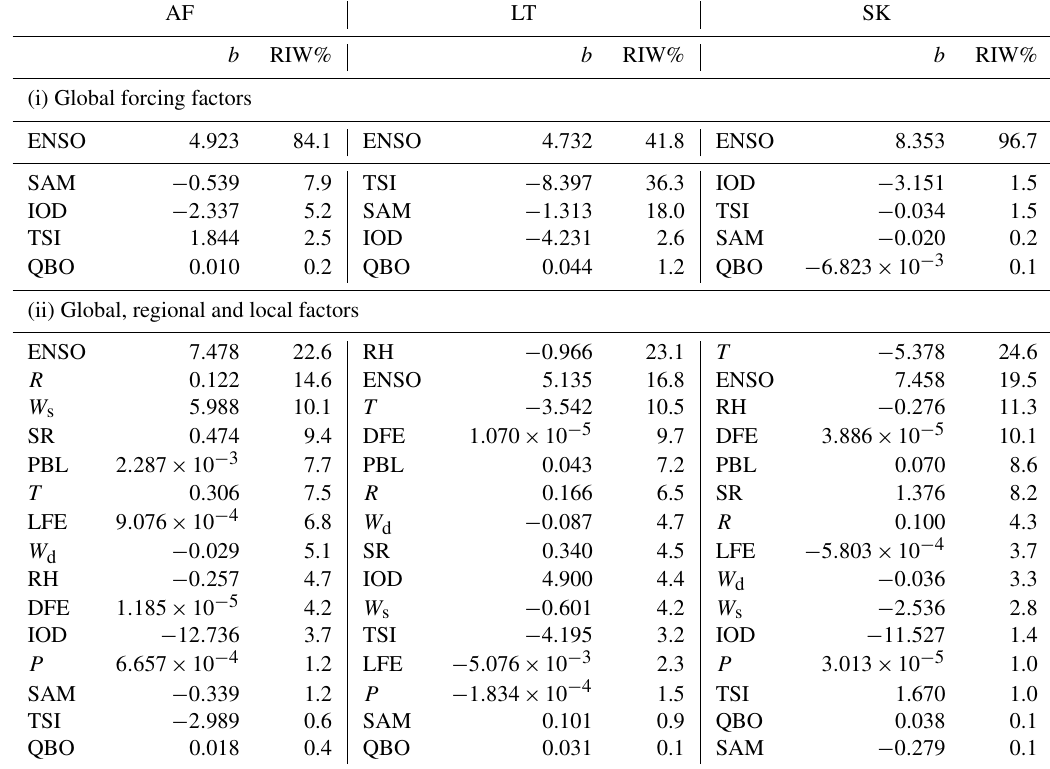
Table 3. Regression coefficients ( b ) and relative-importance weight percentage (RIW%) of each independent variable included in the MLR model to calculate O 3 concentrations at AF, LT and SK.